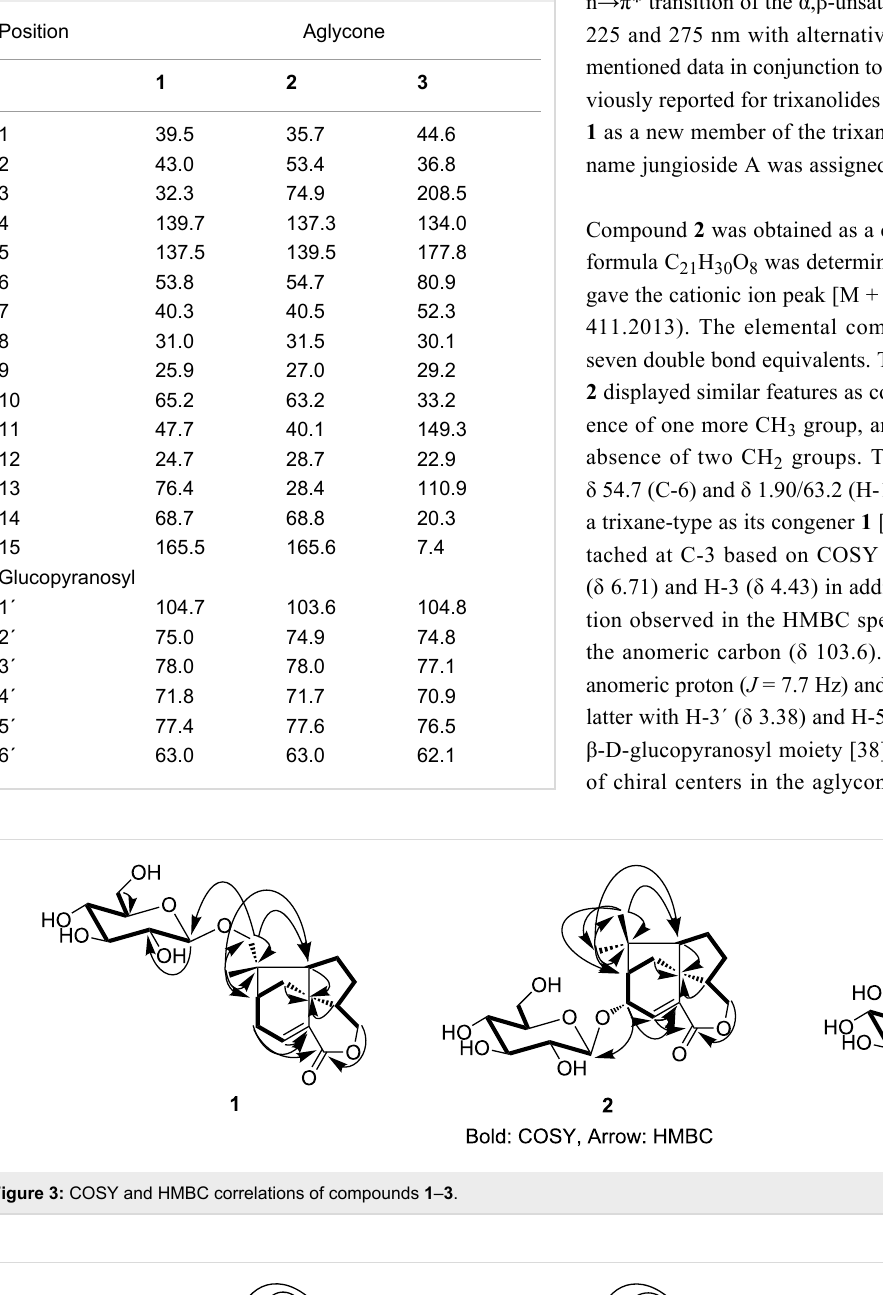
Table 3: 13 C NMR data [100 MHz, (CD 3 ) 2 CO] of compounds 1 – 3